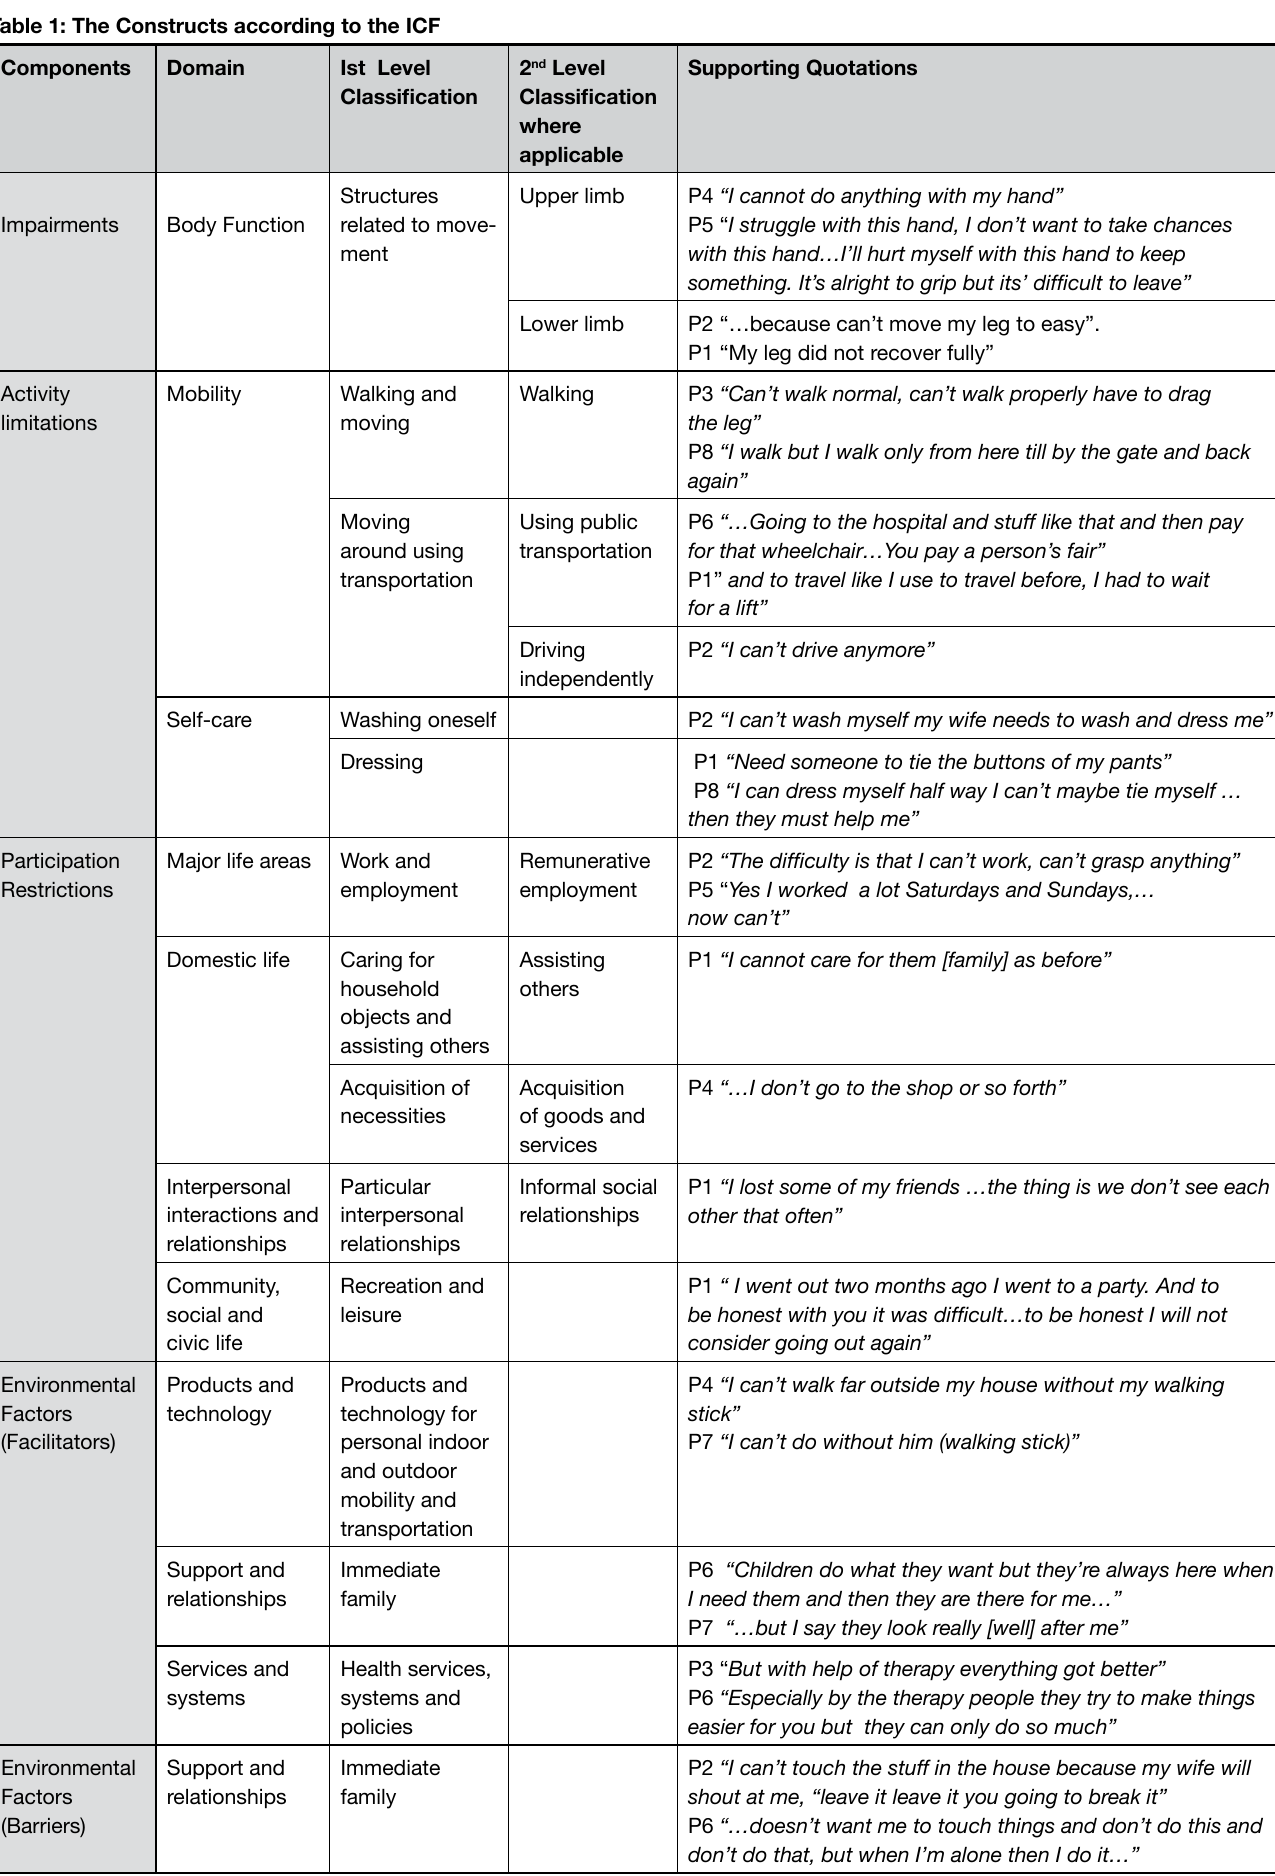
Table 1: The Constructs according to the iCf